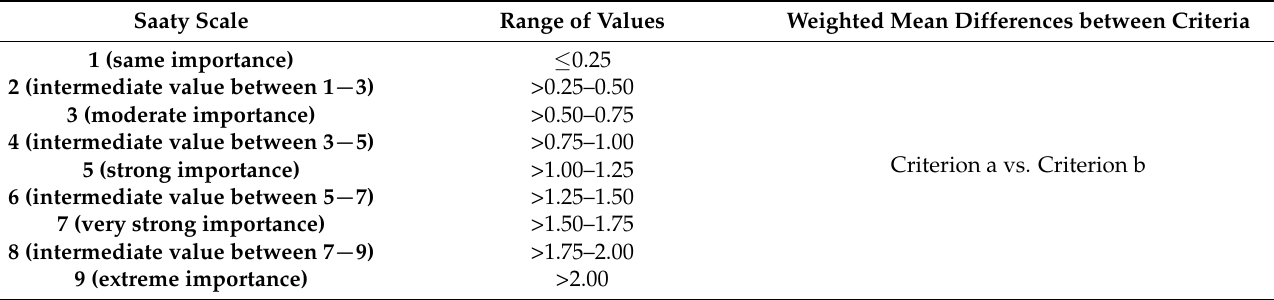
Table 8. Hierarchical Analysis Process preference